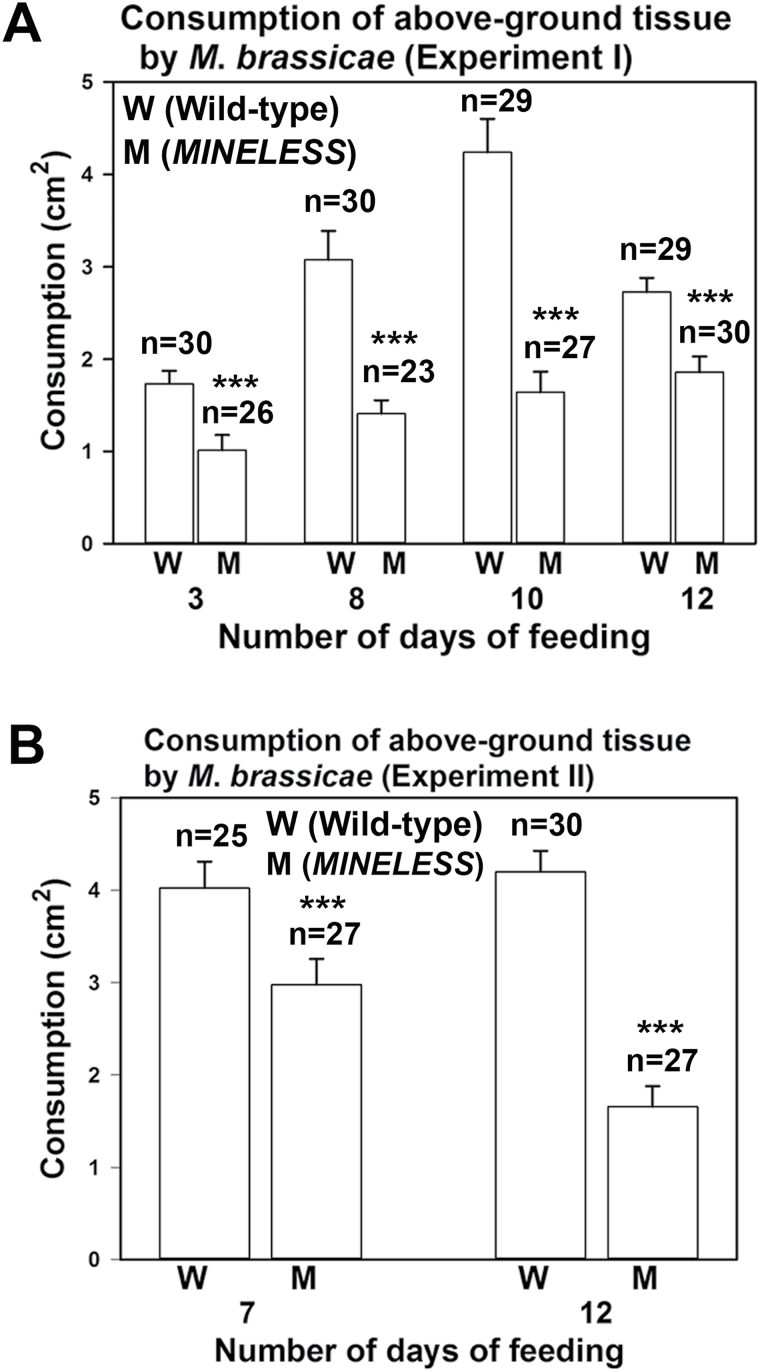
Consumption of wild-type and MINELESS seedlings during M. brassicae no-choice feeding experiments. (A, B) Tissue consumed. n, number of seedlings. Values represent mean ± SE; ***, P < 0.001; *, P < 0.01 (Wilcoxon Mann-Whitney test).